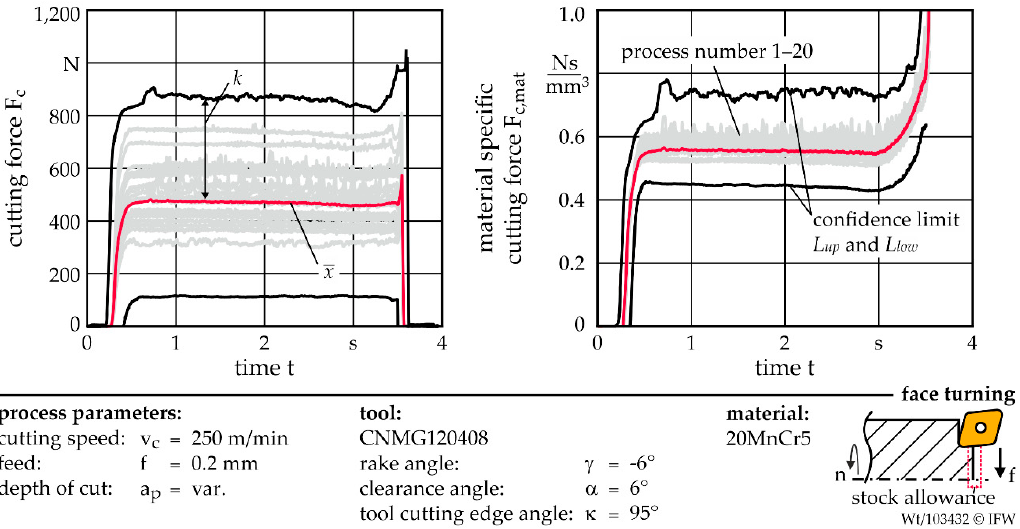
Figure 3. Confidence limits for F c , and F c,mat during face turning process with different depths of cut. To evaluate the sensitivity of the confidence limits of different signal sources the normed bandgap NB was calculated. The NB describes the distance k between the mean value 𝑥̅ and the lower or upper confidence limit L up,low . Thus, NB defines the ratio by which the monitored signal has to change to detect a process error.